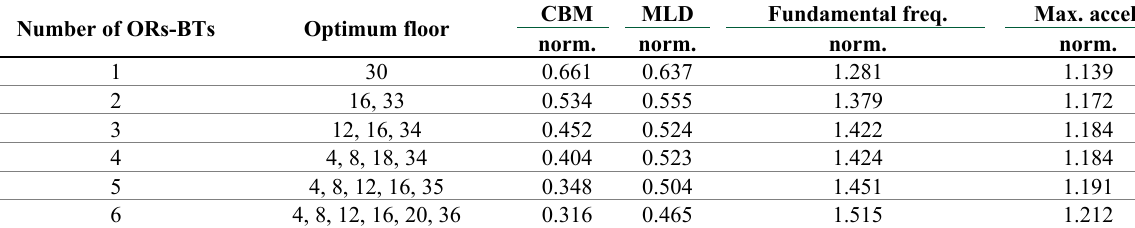
CBM MLD Fundamental freq. Max. accel. norm. norm.